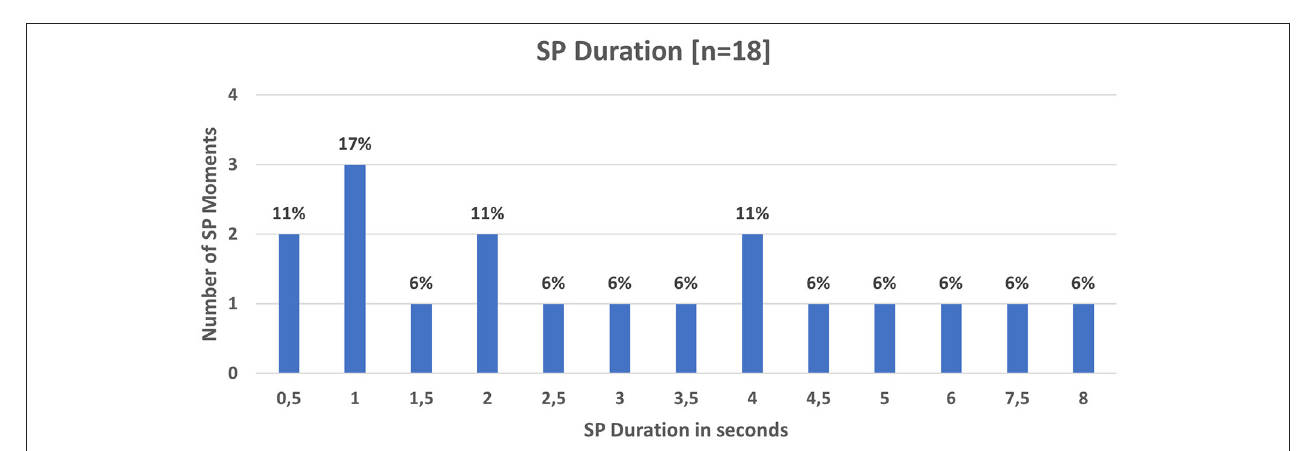
FIGURE 3 | SP moments Frequency and duration ( n = 18).